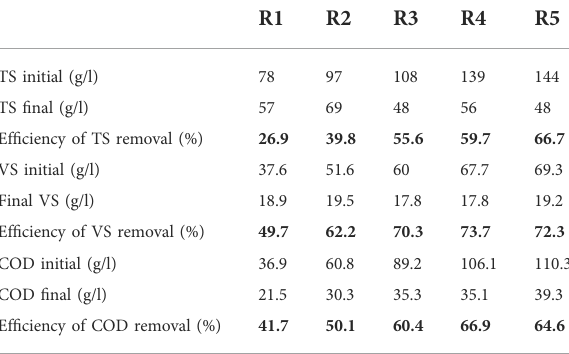
TABLE 2 Removal ef fi ciency of TS, VS, and COD after anaerobic digestion for all mixing ratios.